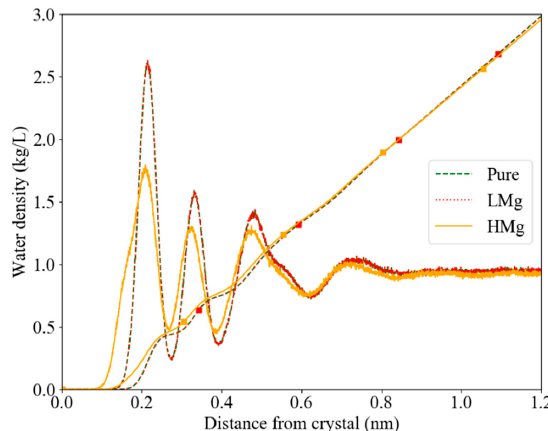
Figure 2. Overall water z -density profile of pure (dashed green, overlaps with dotted red line), low Mg 2+ flat surface (LMgF; dotted red) and high Mg 2+ flat surface (HMgF; yellow) with respect to the flat crystal surface (= 0.0 nm). The lines with the marker ( ) is the integral of the water density. The water dynamics were also altered when a high amount of Mg was incorporated.